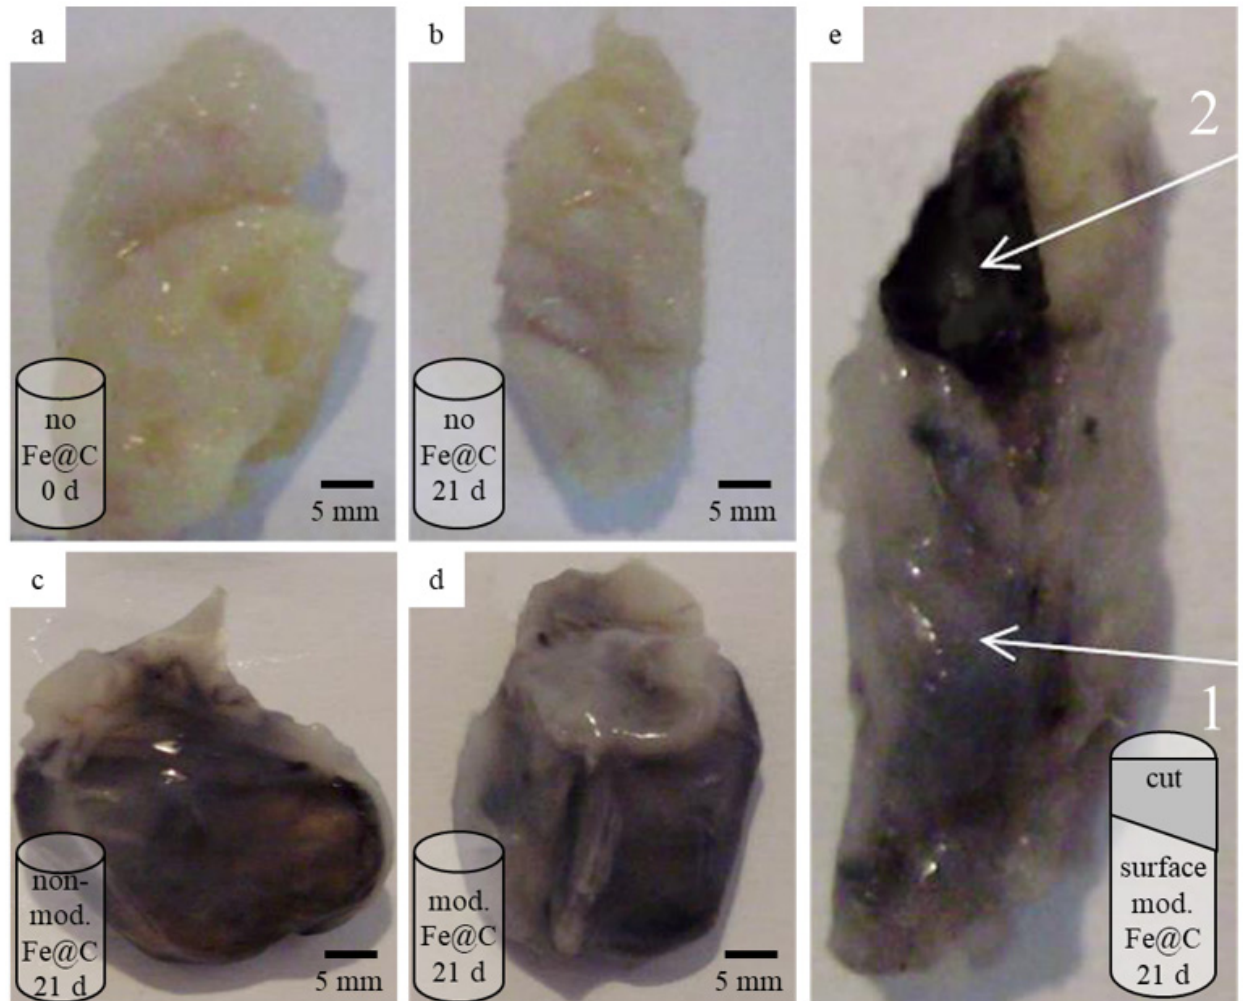
Figure 4. Rolled-up samples of atherosclerotic plaques used for subcutaneous implantation in rat in vivo experiments: ( a ) atherosclerotic plaque in the initial state (before implantation in rats, not treated with NPs); ( b ) atherosclerotic plaque not treated with NPs explanted after 21 days implantation in rat; ( c ) atherosclerotic plaque treated with non-modified Fe@C NPs explanted after 21 days implantation in rat; ( d , e ) atherosclerotic plaque treated with chemically modified Fe@C NPs explanted after 21 days implantation in rat. Schematic representation of plaques samples with depiction of cut sample in ( e ) 1—outer surface of the explanted fragment of the atherosclerotic plaque; 2—area of the cross-section, demonstrating the inner structure of the atherosclerotic plaque.